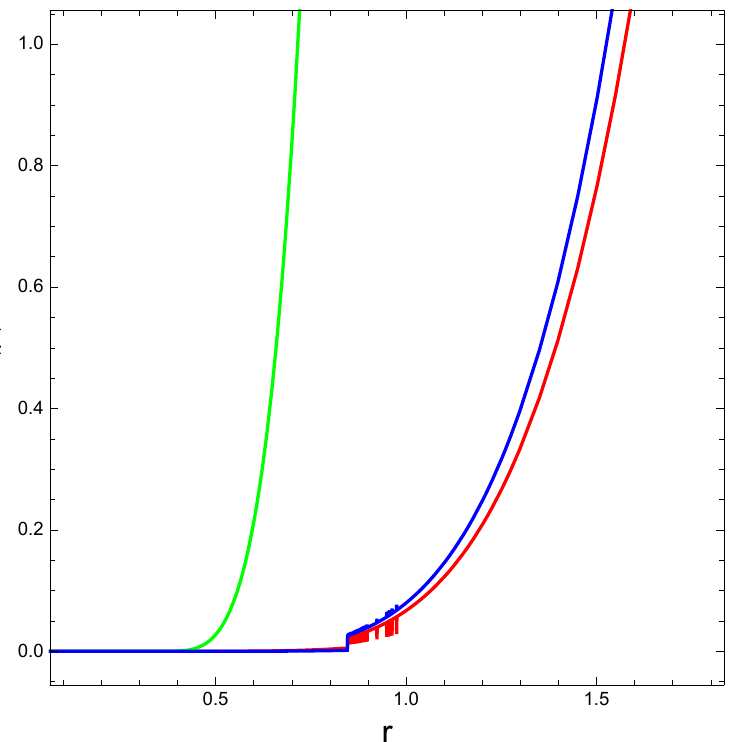
Figure 14. Solution of the scalar potential for R is adopted as an exponential function of radius. The evolution of scalar potential V ( φ 2 ) comparing Equation (8) and Equation (32). We have fixed the values of a 0 , a 1 , a 2 , K , and C 1 . The red, green, and blue lines correspond to small perturbations of λ 0 , Ψ 0 , η 1 , η 2 , and η 3 ,